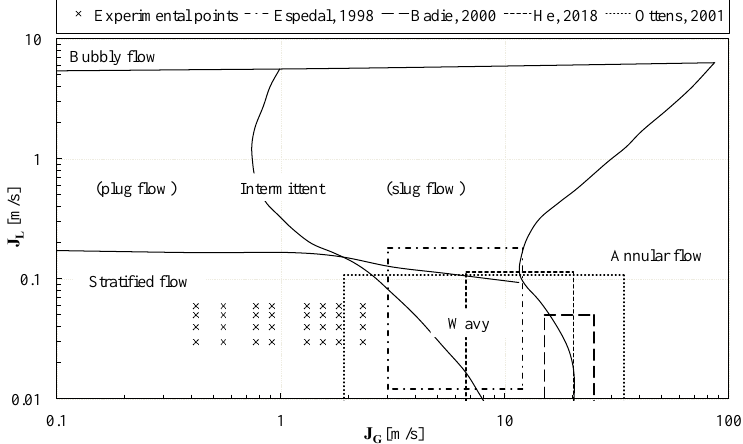
Figure 1. Mandhane map and experimental data for horizontal pipes.